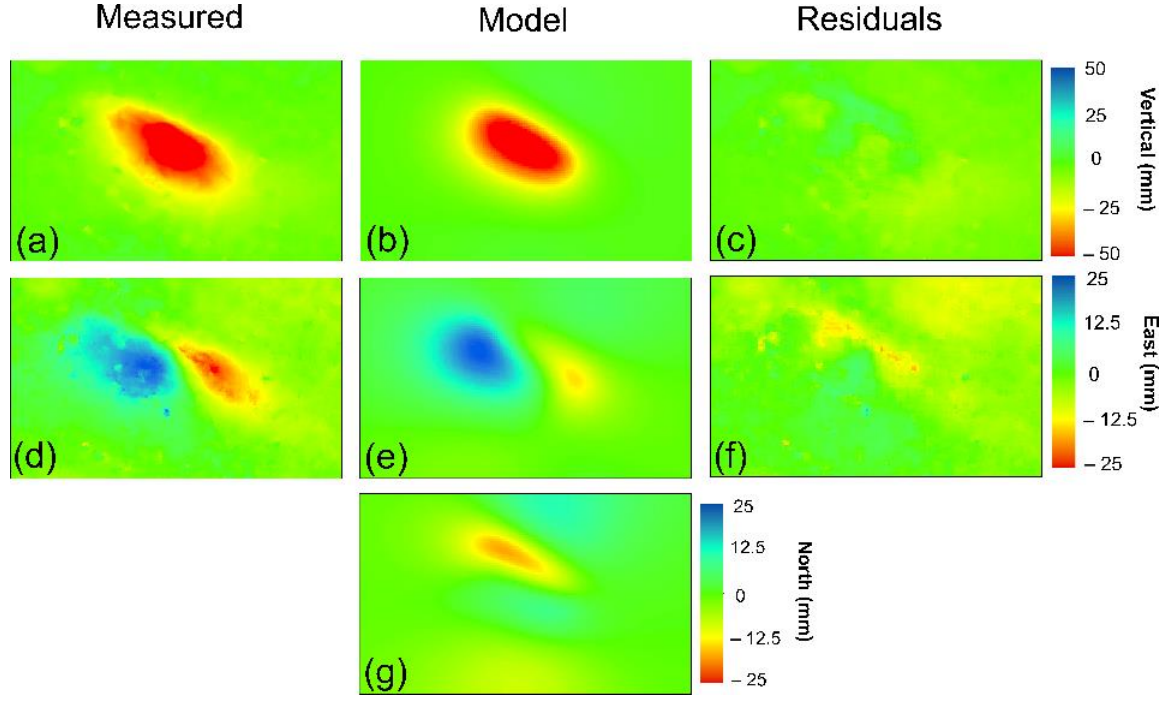
Figure 2. The interferograms used, along with their synthetic interferograms, calculated from the inferred model and the residuals: ( a ) The ascending interferogram of track 102 with ( b ) their corresponding modeled synthetic one and ( c ) the residuals, ( d ) the descending interferogram of track 7 and similar for ( e , f ).